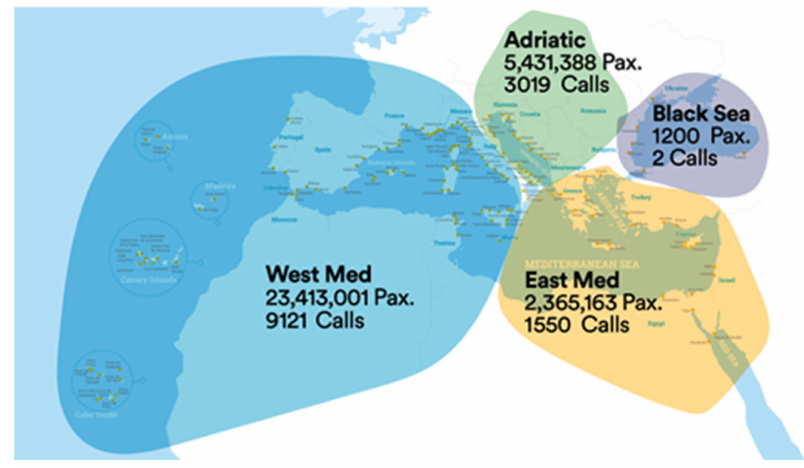
Figure 2. Mediterranean cruise market sub regions [11].